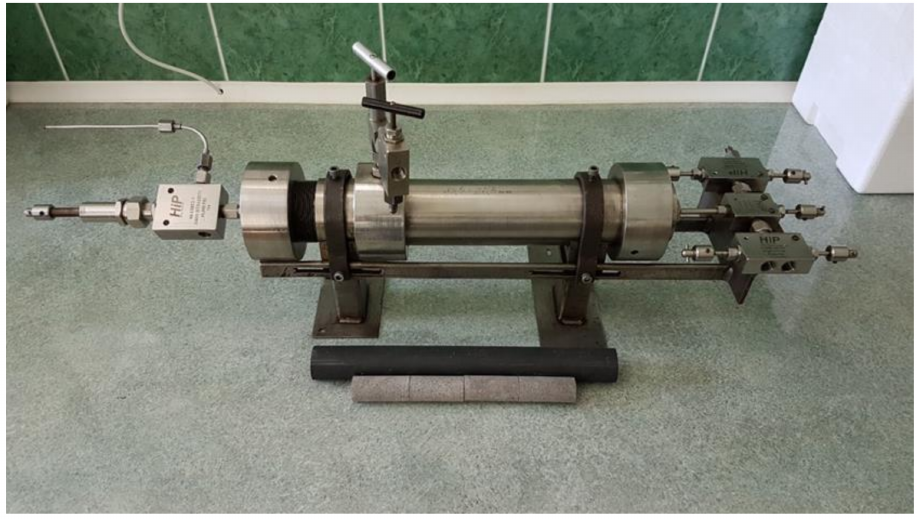
Figure 4. The core holder with rubber sleeve and core plugs forming the composite